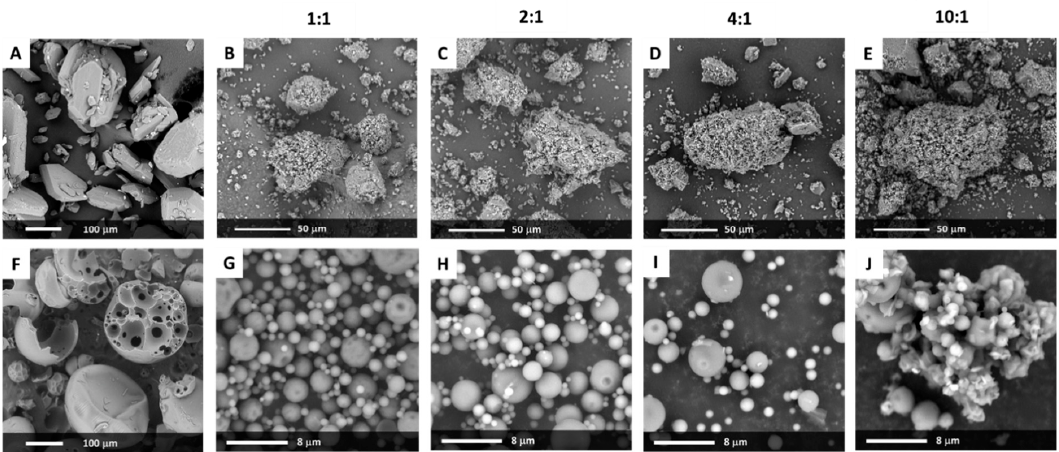
Figure 1. Scanning electron microscopy (SEM) pictures of crystalline bicalutamide (BCL) ( A ), BCL- PVP/VA solid dispersions obtained by either ball milling ( B – E ) or spray drying ( G – J ), and Kollidon ® VA64 ( F ). The composition of binary systems is shown above the pictures.